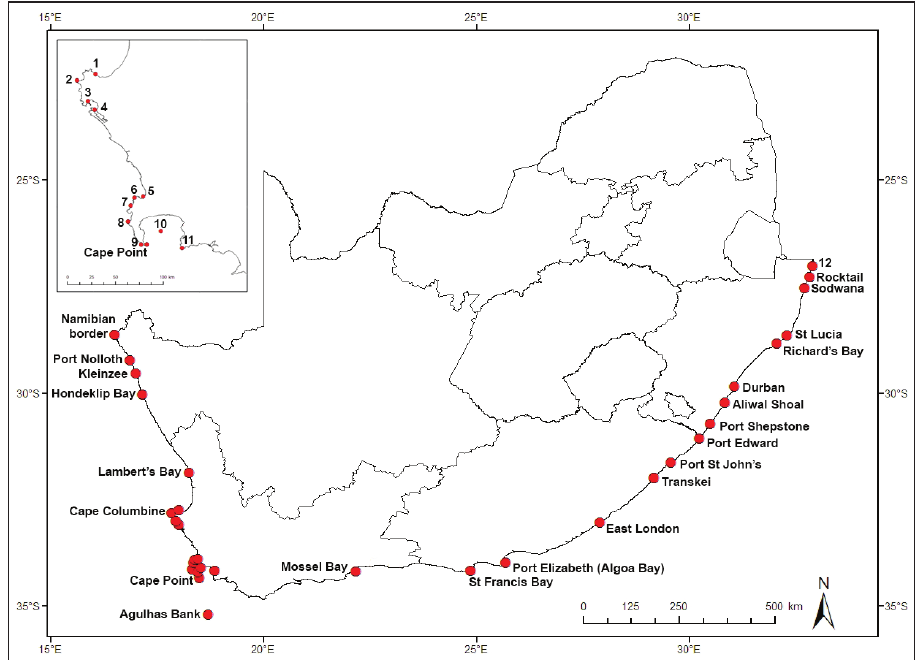
Figure 1. Map of South Africa showing places mentioned in the text: 1 St Helena Bay 2 Cape Colum- bine 3 Saldanha Bay 4 Langebaan Lagoon 5 Table Bay 6 Sea Point 7 Oudekraal 8 Kommetjie 9 Cape of Good Hope 10 False Bay 11 Cape Hangklip, and 12 Bhanga Nek (Mozambique